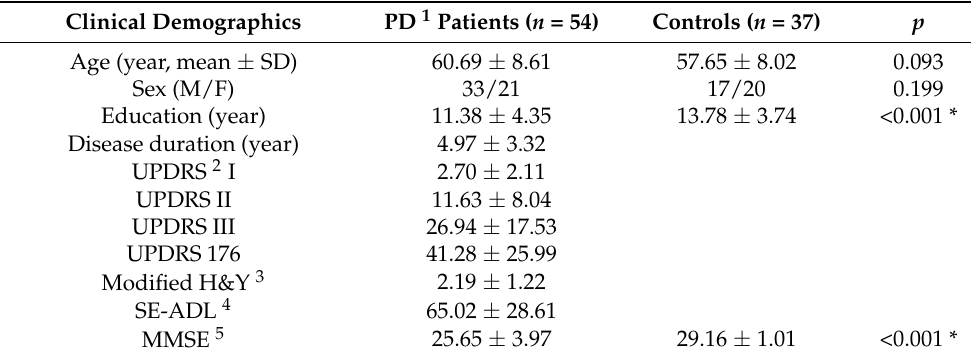
Table 1. Basic demographic data. Data are presented as mean ± standard deviation. Sex data were compared with Pearson chi-square test. Age data were analyzed with independent t -test. MMSE were compared using ANCOVA after controlling age, sex, and education